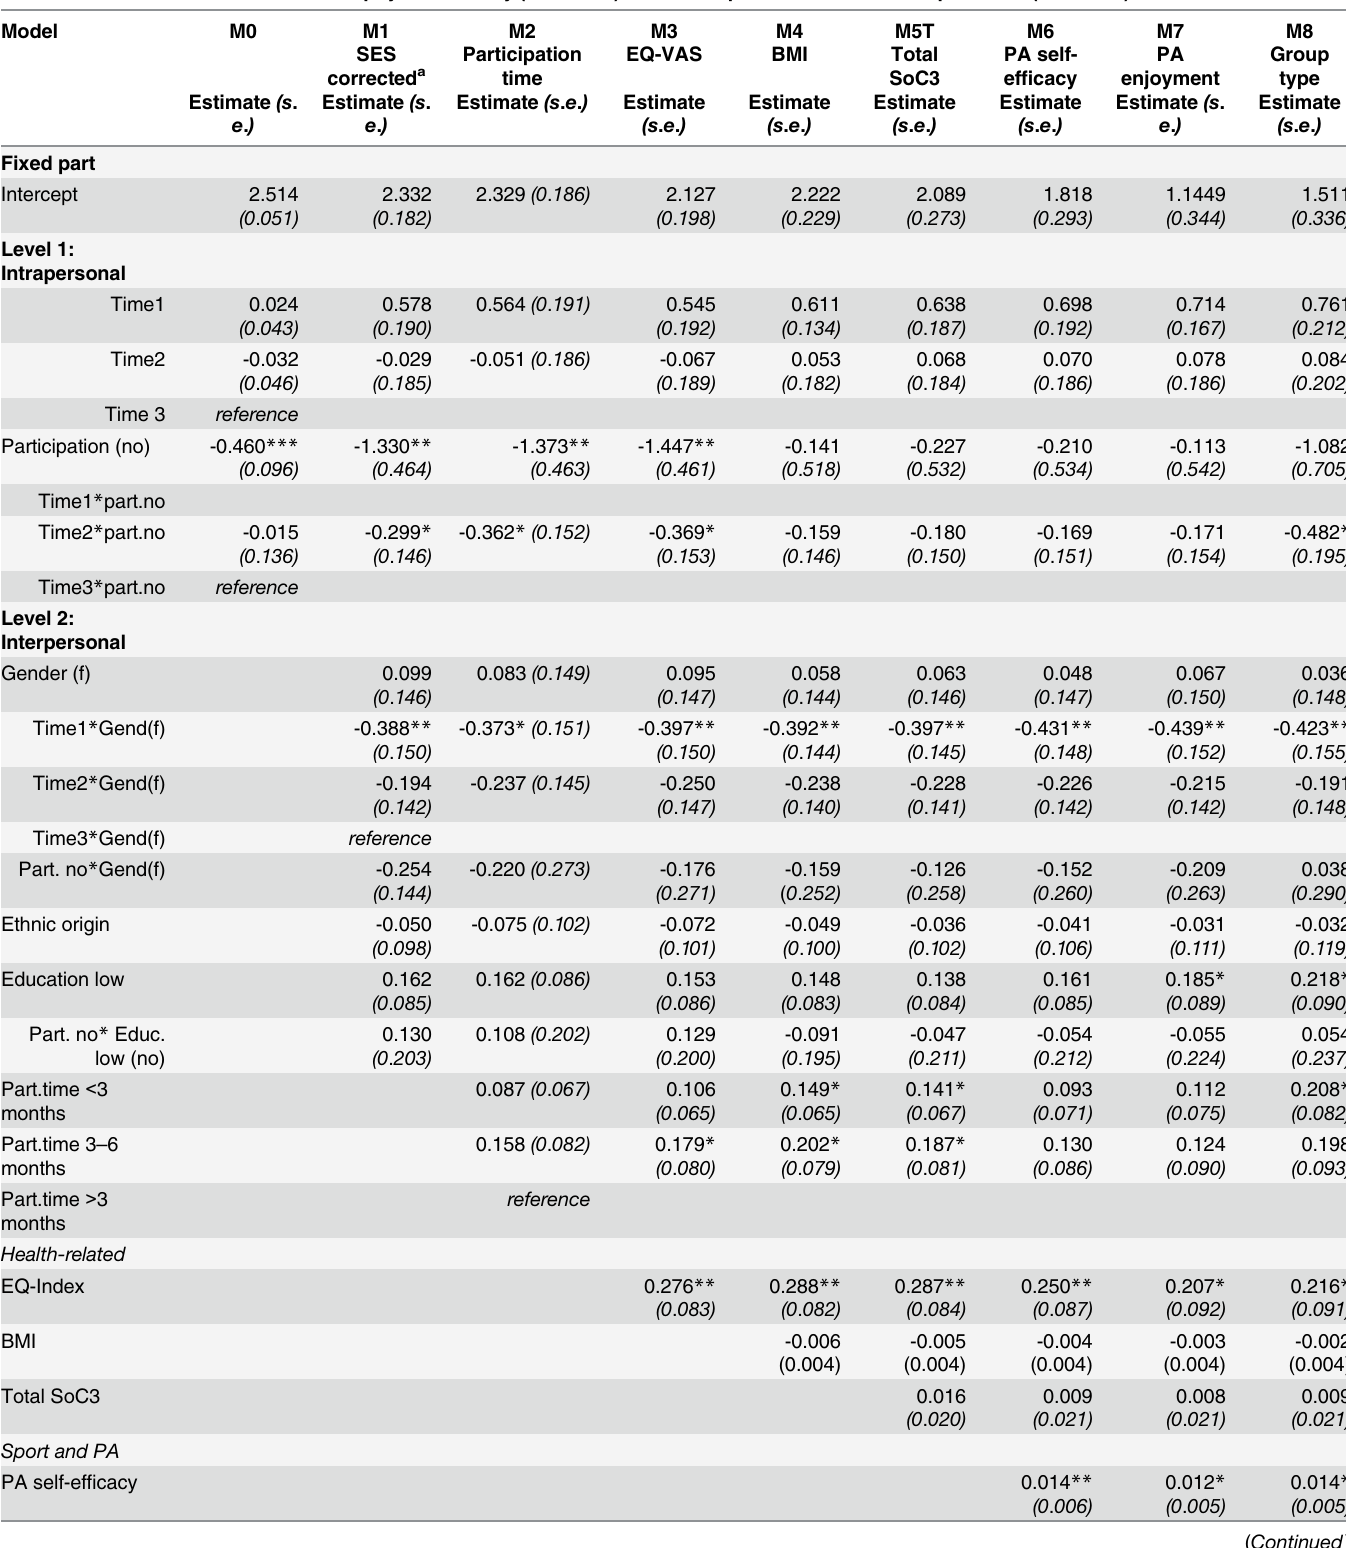
Table 8. Growth model for leisure-time physical activity (min/week) with self-reported levels of health problems